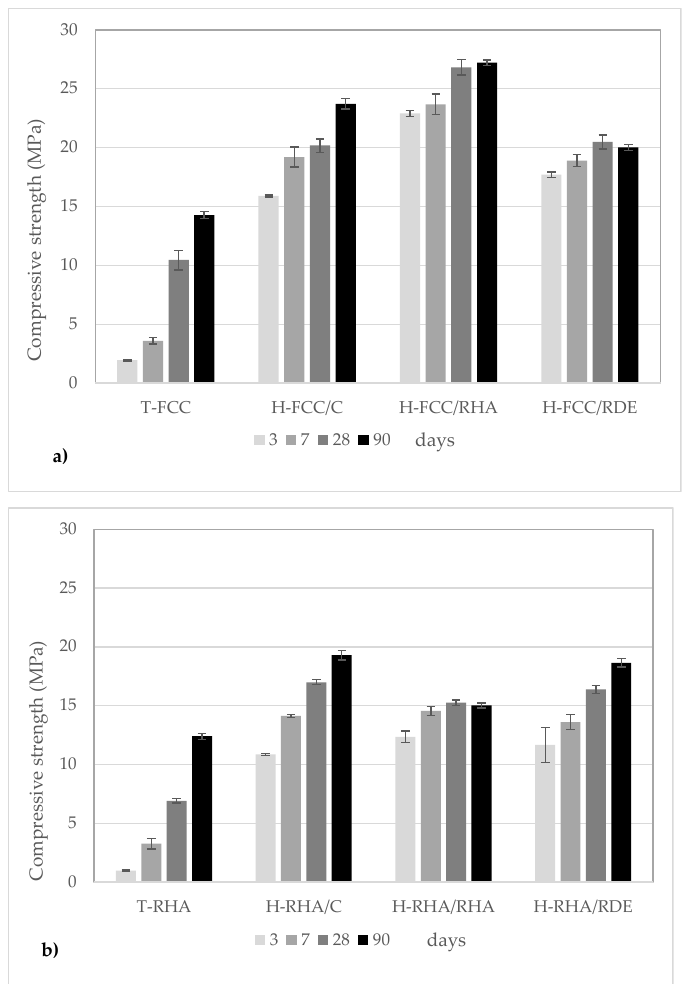
Figure 3. Compressive strength of mortars after 3, 7, 28 and 90 curing days: ( a ) FCC systems; ( b ) RHA systems.